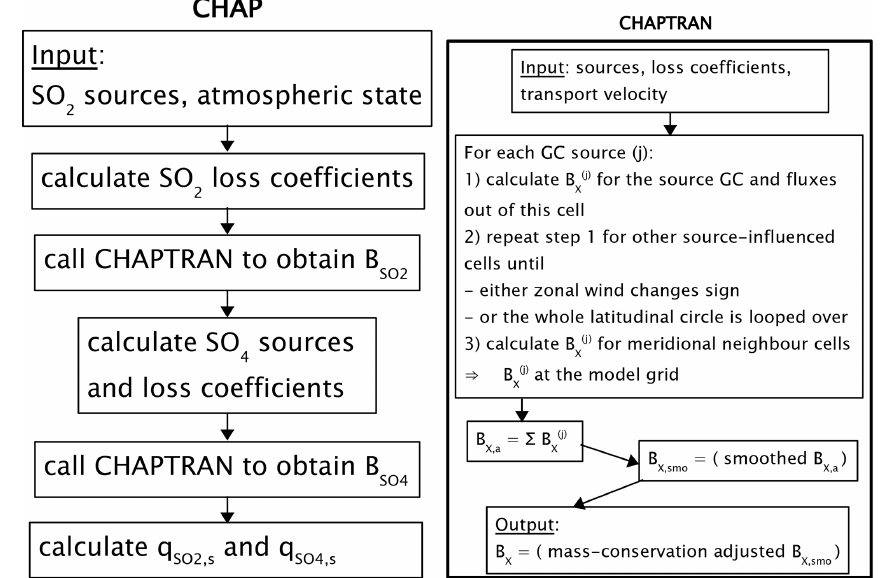
Figure 2. An illustration of ChAP data flow. GC stands for grid cell.